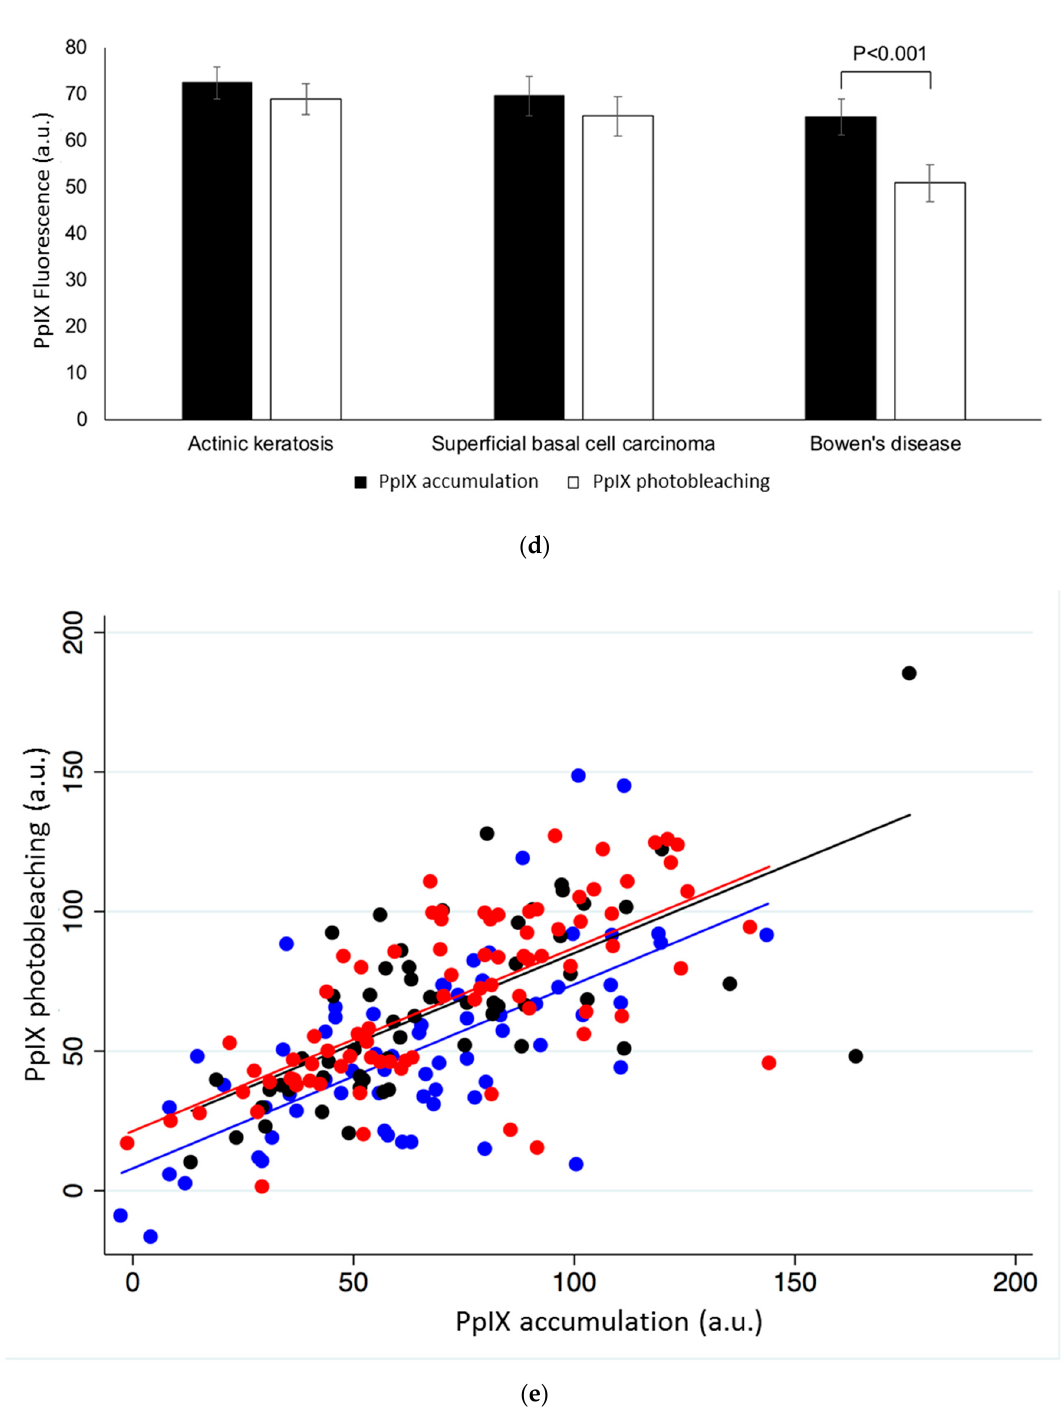
Figure 1. Representative (false color coded) PpIX fluorescence images of an individual superficial basal cell carcinoma (sBCC) (upper back, 70 year old female) ( a ) before methyl aminolevulinate (MAL) application, ( b ) three hours later prior to irradiation and ( c ) immediately following irradiation. Actinic keratosis (AK), sBCC and Bowen’s disease (BD) lesions ( d ) accumulate more PpIX than is photobleached during MAL-induced PDT irradiation (mean PpIX fluorescence is presented in arbitrary units (a.u.) with bars indicating the standard deviation) and ( e ) PpIX accumulation and photobleaching (a.u.) is correlated in each licensed lesion type during MAL-PDT, with red dots representing AK, black dots representing sBCC and blue dots representing BD. The lines of best fit are also presented and the R 2 values for each lesion are: AK 0.47, sBCC 0.45 and BD 0.43; overall R 2 =